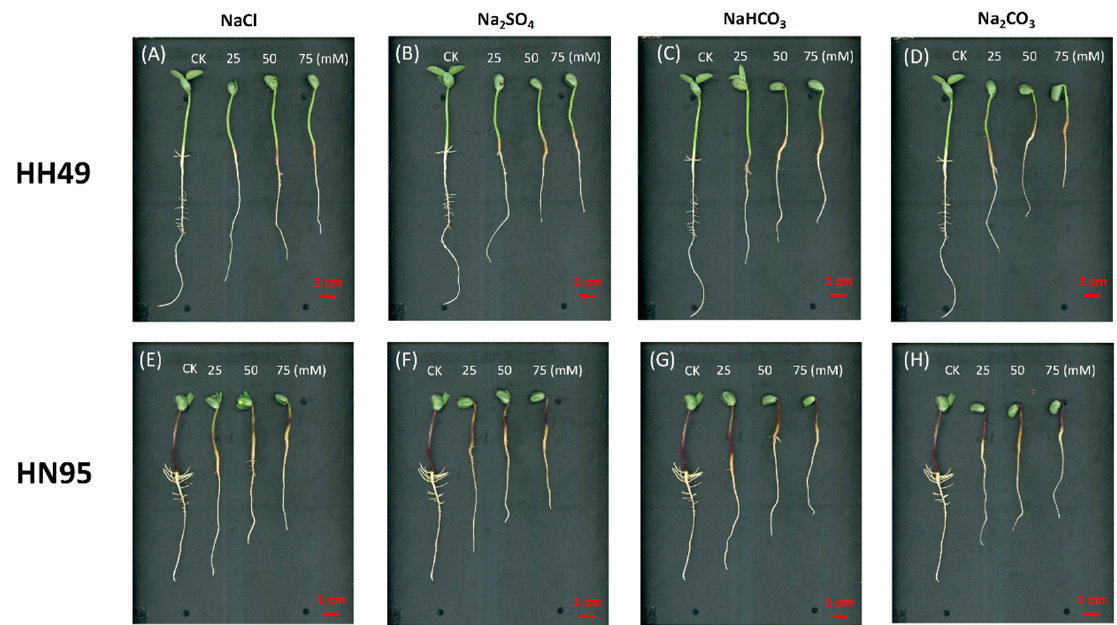
Figure 1. The phenotypes of HH49 and HN95 seedling roots treated with different salt treatments for 3 days . ( A – H ) Na + concentrations of the treatments solutions were set as 0, 25, 50, and 75 mM in formulas of NaCl, Na 2 SO 4 , NaHCO 3 , and Na 2 CO 3 , separately, and Bar = 1 Table 1. Effects of different salt treatments on root growth of HH49 and HN95 seedlings. Cultivars Treatments